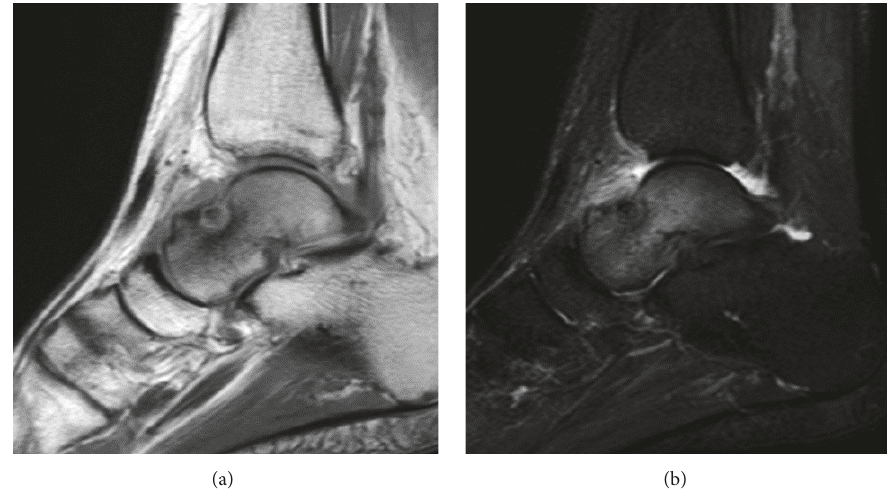
Figure 3: T1-weighted (a) and short T1 inversion recovery (b) sagittal magnetic resonance imaging showing a bone lesion in the talar neck with surrounding bone marrow edema and synovitis in front of the bone